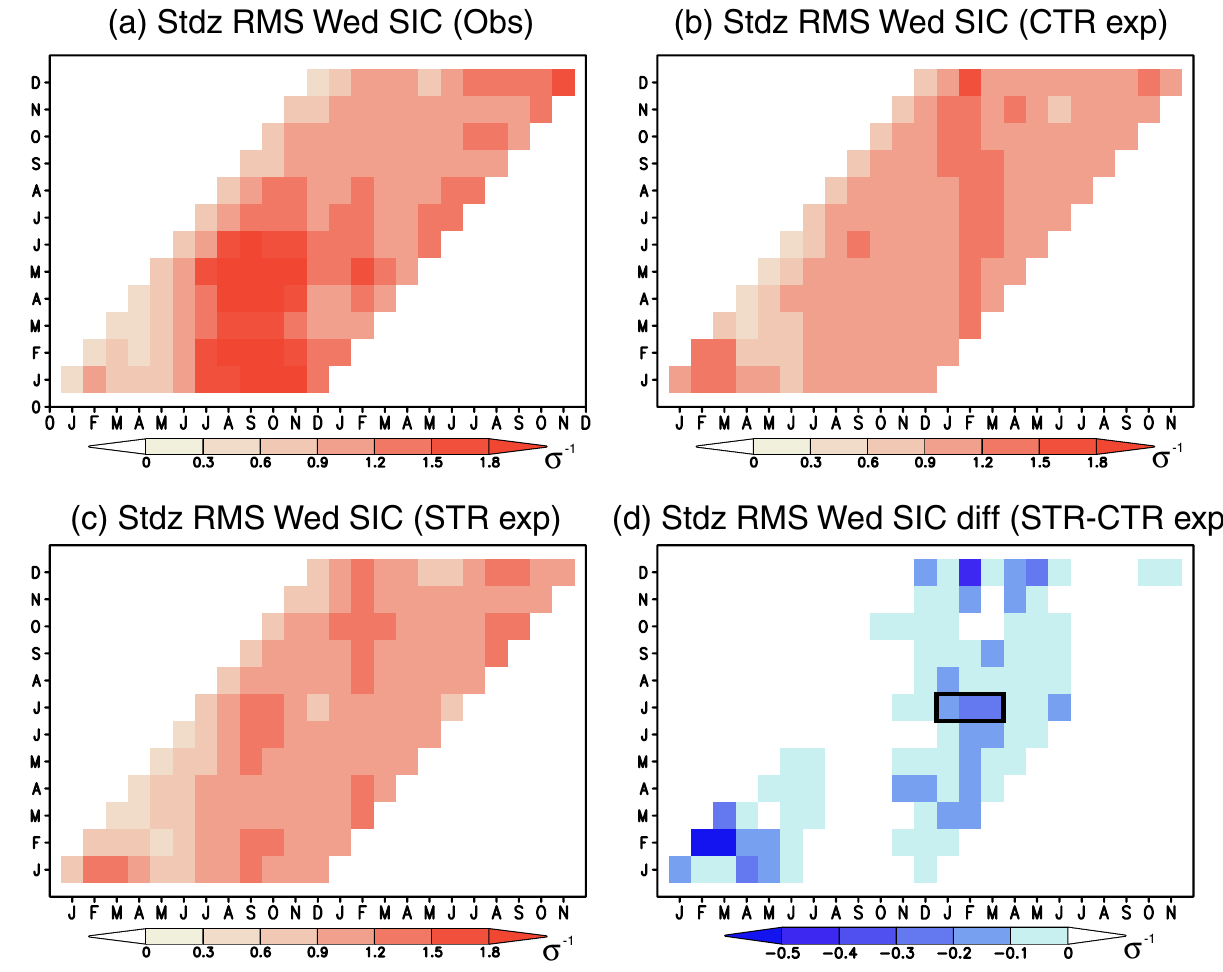
Figure 3. ( a ) Standardized root mean squared errors (RMSs) for the persistence prediction using the observed SIC anomalies averaged in the Weddell Sea (70° S–60° S, 55° W–40° W; see the black boxes in Fig. 6. X-axis denotes predicted months, while Y-axis denotes initial months. For standardization, we use the observed standard deviation for each month. ( b ) Same as in ( a ), but for the standardized RMSs between the observed SIC anomalies and the predicted SIC anomalies in the CTR experiment. ( c ) Same as in ( b ), but for the standardized RMSs using the predicted SIC anomalies in the STR experiment. ( d ) Differences in the standardized RMSs between the STR and CTR experiments, i.e., ( c )–( b ). Only negative values are shown to highlight improvement of the simulated amplitude in the STR experiment. A black box indicates January–March of research